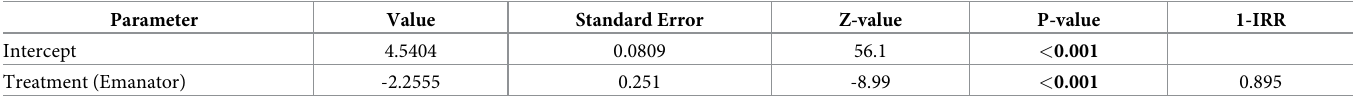
In parenthesis is listed the variable used as baseline for effect estimation. For treatments showing a significant reduction in HLC, we estimated the efficacy, as 1— Incidence Rate Ratios (IRR). Bolded p-values are less than 0.05 and statistically